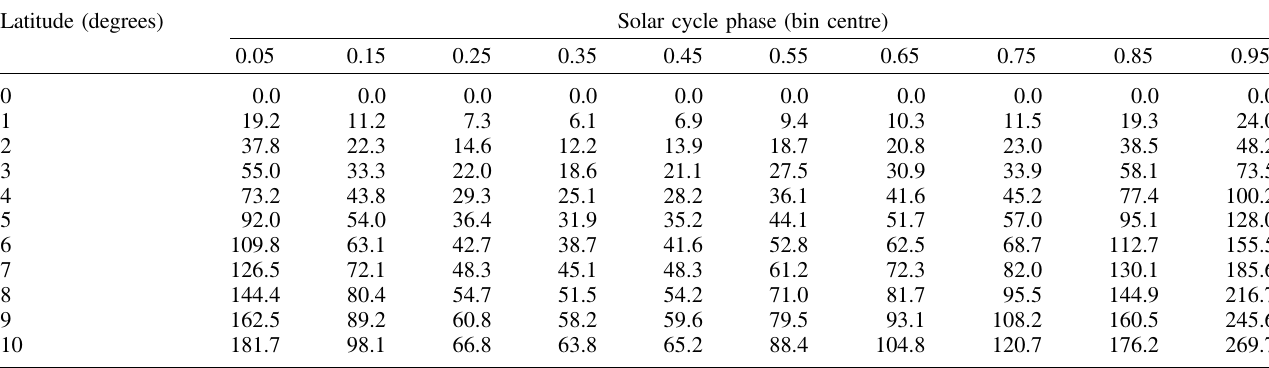
Table 2. The inter-quartile range of the solar wind speed differences between the equator and other latitudes, i.e. V 0 (cid:3) V h , as a function of solar cycle phase and latitude. All values are given in km s (cid:3) 1 .